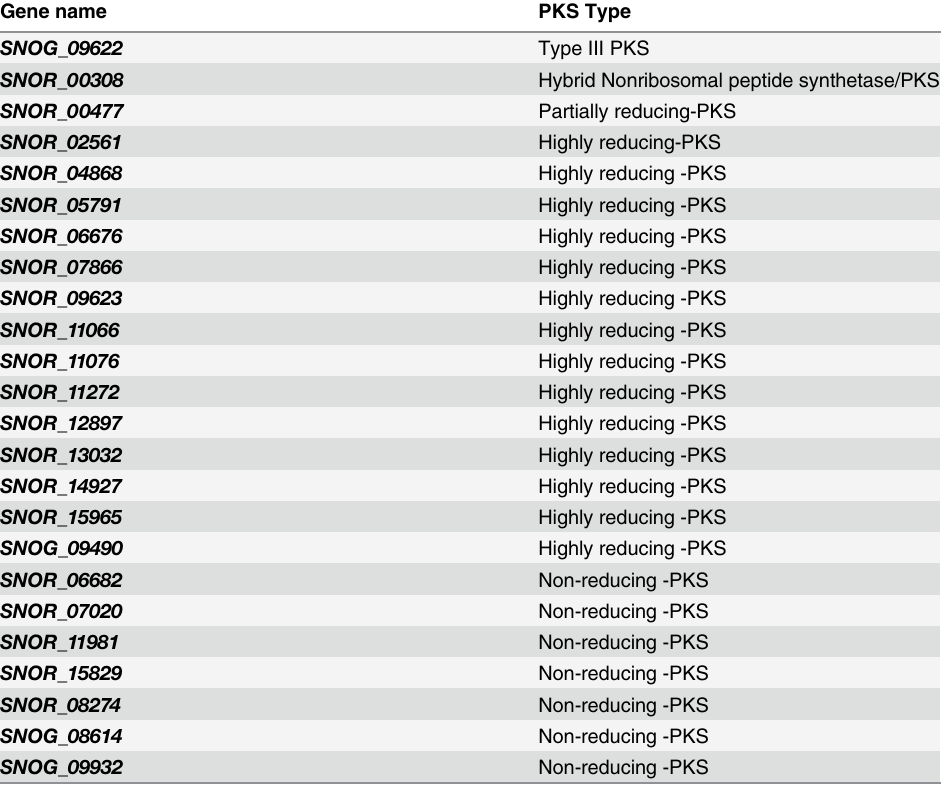
Table 6. Polyketide synthase genes of P . nodorum